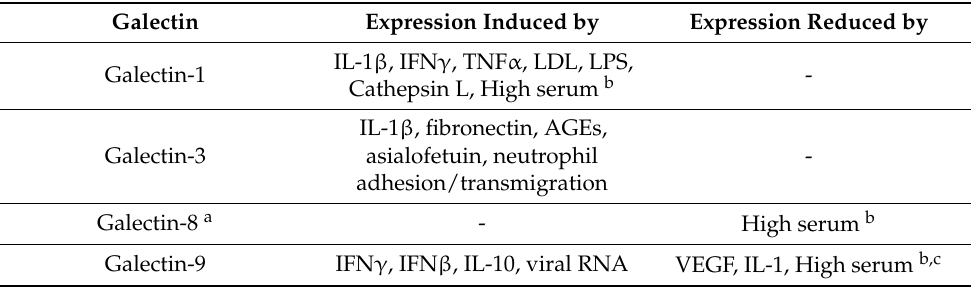
Figure 2. Endothelial galectins. ( a ) Schematic representation of the four dominant galectins that are expressed by endothelial cells. ( b ) Overview of the main post-transcriptional and post-translational modifications that occur in endothelial galectins. Note that the modifications shown here are illustrative and do not represent the actual location of modification in the respective proteins. Table 1. Regulators of endothelial galectin